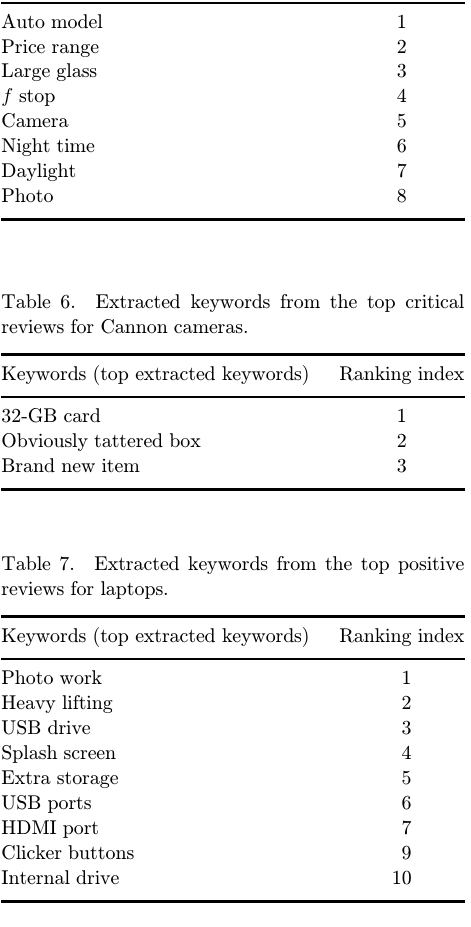
Table 5. Extracted keywords from the top positive reviews for Cannon cameras. Keywords (top extracted